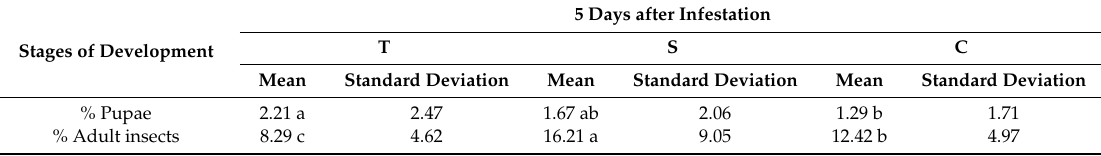
Table 1. Comparison of the traditional method with scalpel ( T ) without contrast radiography ( S ) and with contrast radiography ( C) in relation to the evaluation of the presence of adult insects of Sitophilus zeamais causing damage in maize seeds after 5 days of infestation. 5 Days after Infestation Stages of Development